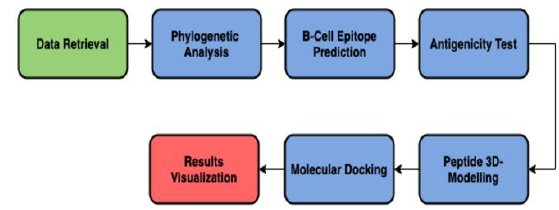
Figure 1. The brief summary of the analysis that had been conducted starting from the sample retrieval to the visualization of the molecular docking